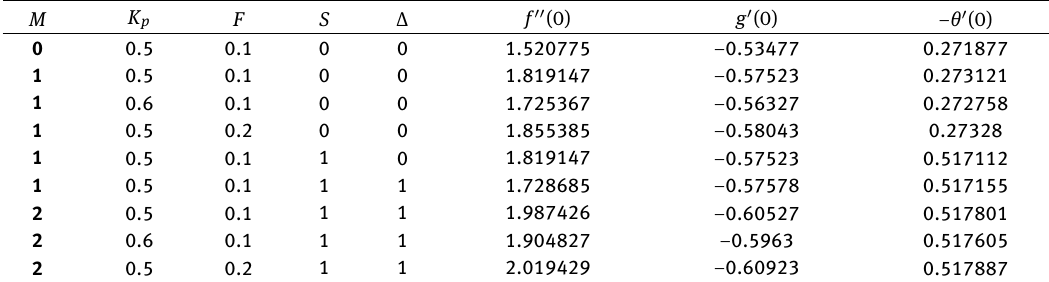
Table 1: Skin friction, wall couple stress, Nusselt number for the values of R = 0.1, G = 2 . M K p F S ∆ f (cid:48)(cid:48) (0) g (cid:48) (0) − θ (cid:48) (0)